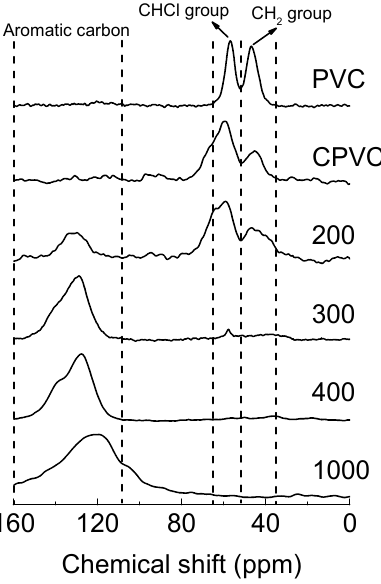
Figure 4. The solid-state 13 C nuclear magnetic resonance spectroscopy ( 13 C-NMR) spectra of the PVC, CPVC and carbonised intermediates of the CPVC spun fibres, at 200, 300 and 400 °C, and the CPVC carbon fibre heat treated at 1000 °C.